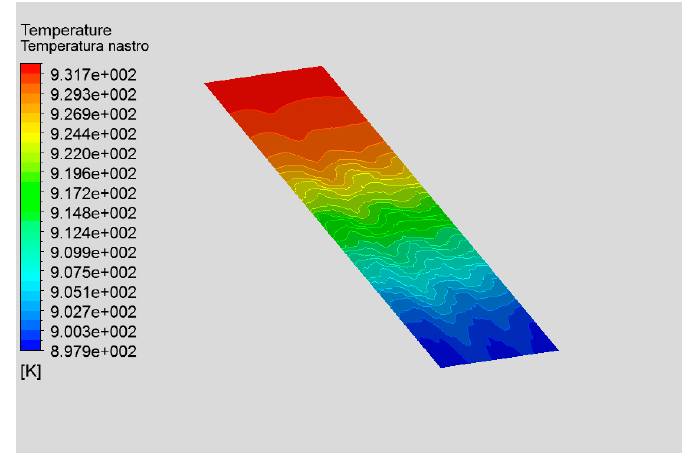
Figure 18. Surface temperature of the band.